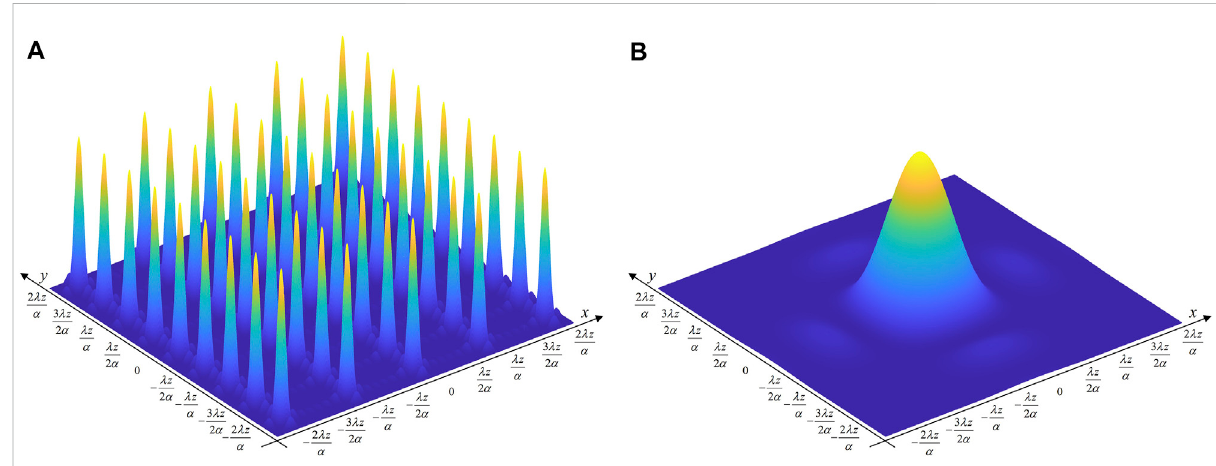
FIGURE 4 Value distribution of (A) the multibeam interference factor and (B) the single-beam diffraction